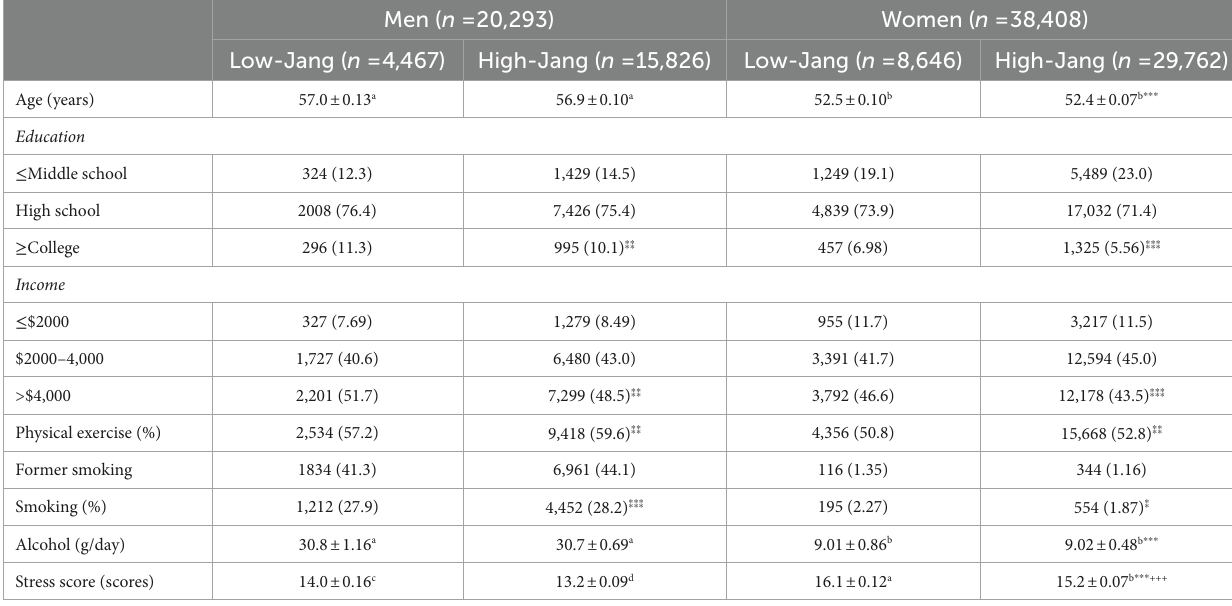
Values represents means and standard deviations for continuous variables and numbers and percentage for categorical variables. The cutoffs of Jang intake were <1.9 g/day. Stress status was estimated with 18 questions about the physical and psychological at home and work, and each question was scored 0 (lowest stress) to 3 (highest stress). The scores of the stress status were estimated with a summation of the scores of 14 questions. The higher scores of the stress status indicated having higher stress. *** Significant differences by genders at p < 0.001. +++ Significant differences by Jang intake at p < 0.001. ‡‡‡ Significantly different from the low-Jang group in χ 2 test in each gender at p < 0.001. a,b,c,d Different superscripts on the values indicated significant differences among the groups in Tukey’s test at p < 0.05. TABLE 2 Food intake according to gender and Jang intake.